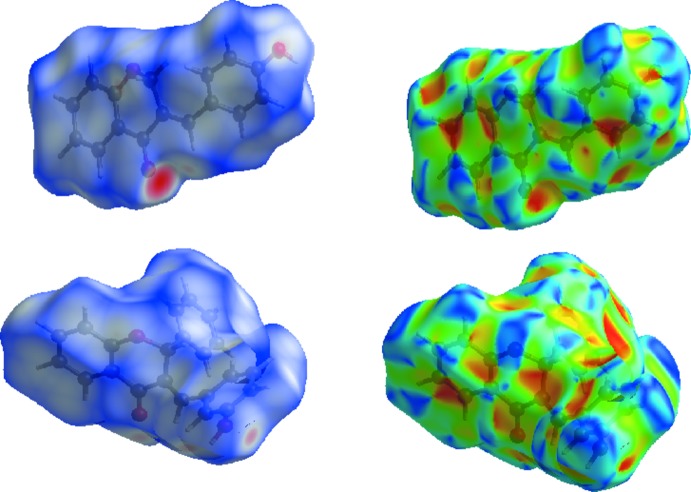
View of the three-dimensional Hirshfeld surfaces of the title compounds plotted over d
norm (left) and shape-index (right); first row: compound I, second row: compound II.